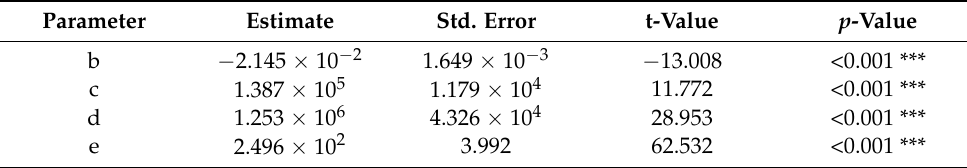
Table 1. Parameter